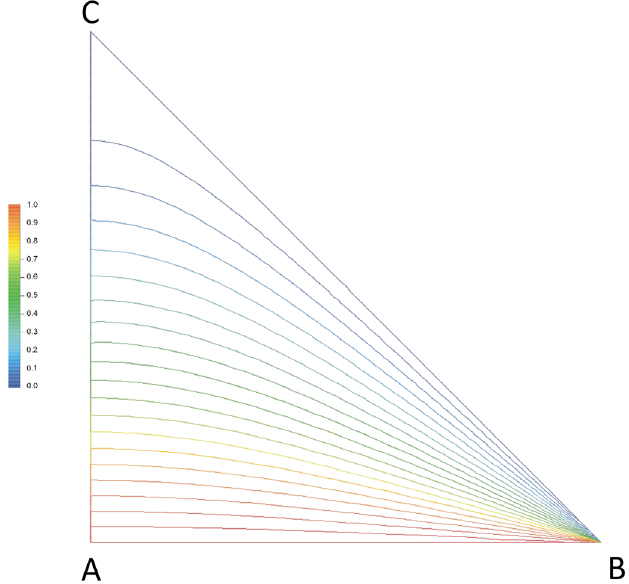
Fig. 3. Stream function contour of the square cavity with boundary condition on the walls, AB and CD, ∂ u ∂ BC, u = 0, Pr = 0.71, Ra = 10 5